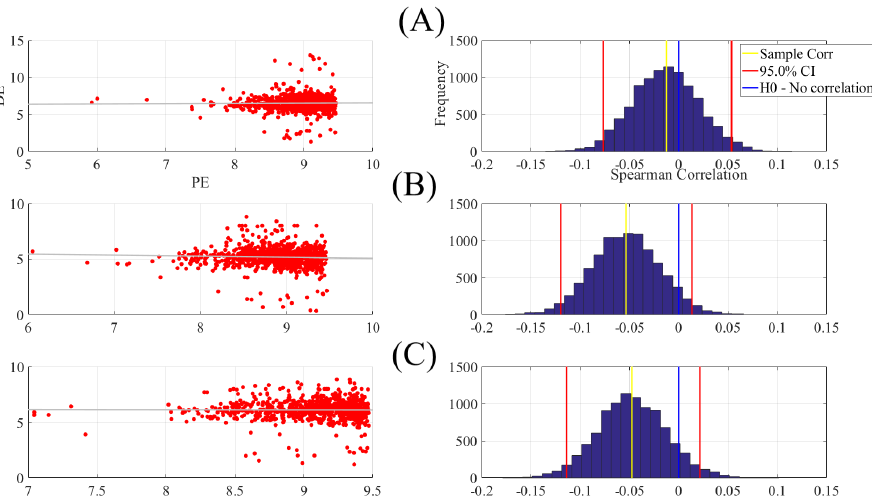
Figure A20. Spearman correlation between participants’ DEs (i.e., 62 DEs associated with 62 EEG channels of a participant, per affect) and their corresponding PE7s (i.e., 62 PE7s associated with 62 EEG channels of a participant, per affect) in ( A ) negative, ( B ) neutral, and ( C ) positive. The subplots on the right column correspond to the bootstrap correlation test (10,000 simulation runs) at 95.0% confidence interval.